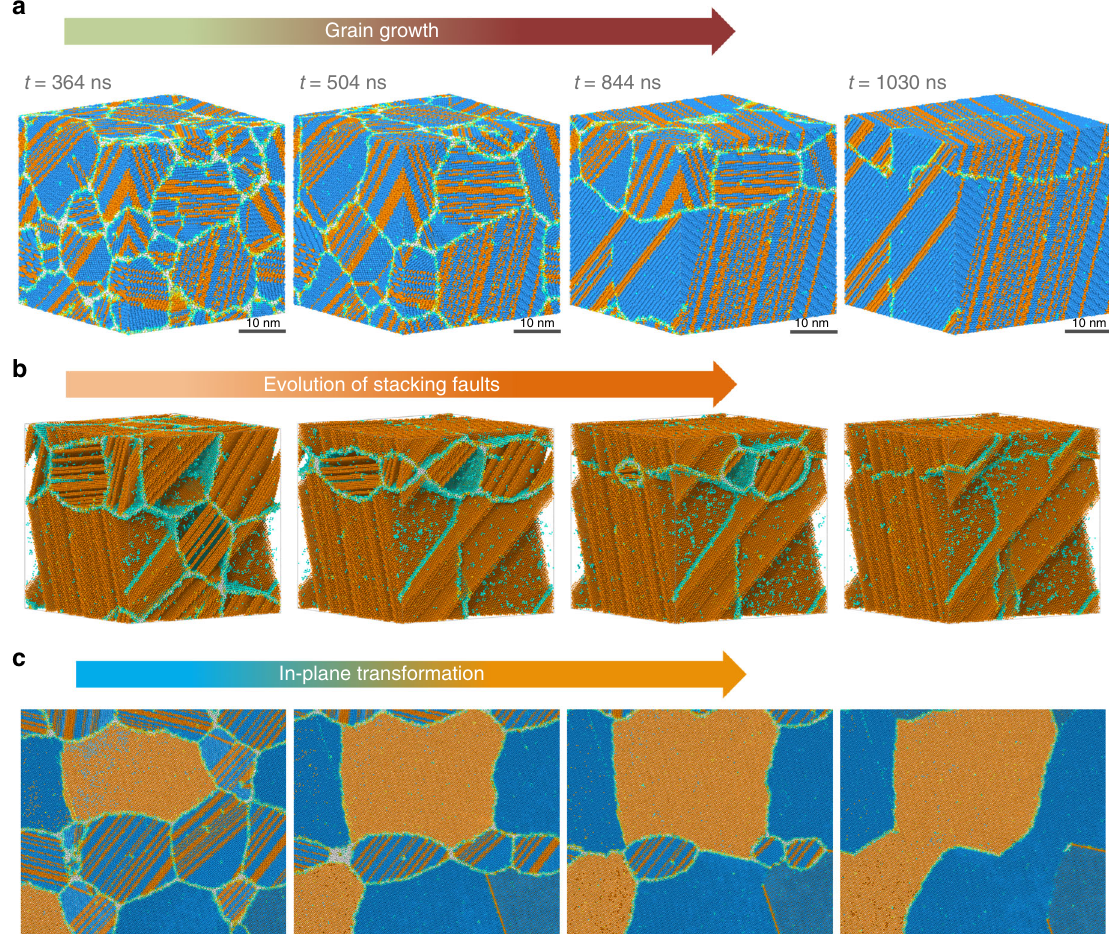
Fig. 5 Post-nucleation ice grain growth simulations performed using ML-BOP dih . System dynamics and evolution of structural motifs of post-nucleation phase after the slow heating from 210 to 260 K. a Snapshots from simulations showing the grain growth process of nanosized grains at 260 K evolving into a single grain. (see Supplementary Movie 2 for a zoom-in view) b Snapshots from simulations (Supplementary Movie 3) showing the time evolution of hexagonal layers in stacking disordered ice. Cubic type molecules are not shown for clarity. Note that the ML-BOP model considers only nearest neighbor interactions but is able to reproduce the random stacking-disorder which is consistent with experimental observations 31 . c Snapshots from simulations (Supplementary Movie 4) showing the in-plane transformation between cubic and hexagonal layers in stacking disordered ice, viewed along the direction perpendicular to the basal plane of the largest stacking ice grain in the